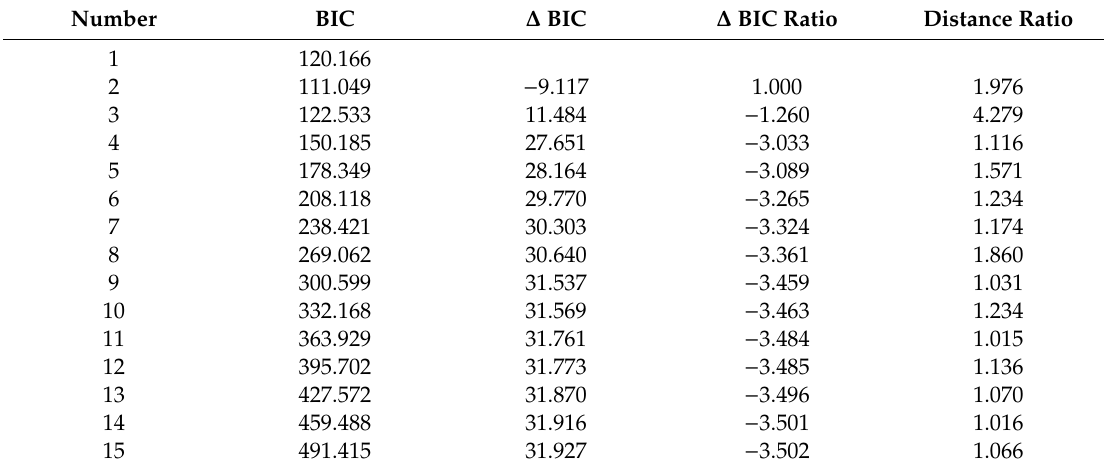
Table 2. Number of clusters based on the Schwarz Bayesian Inference Criterion (BIC).